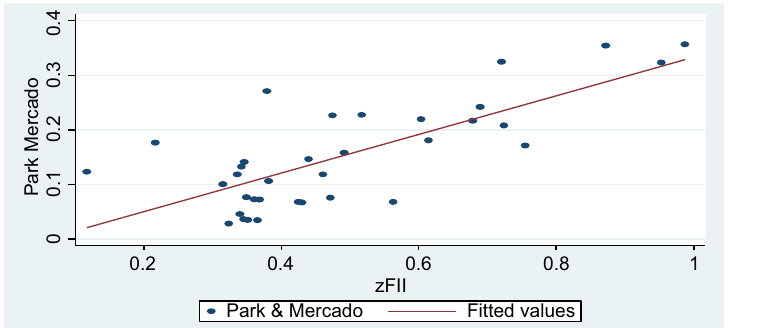
Figure 4. FI index and index of FI from Park and Mercado